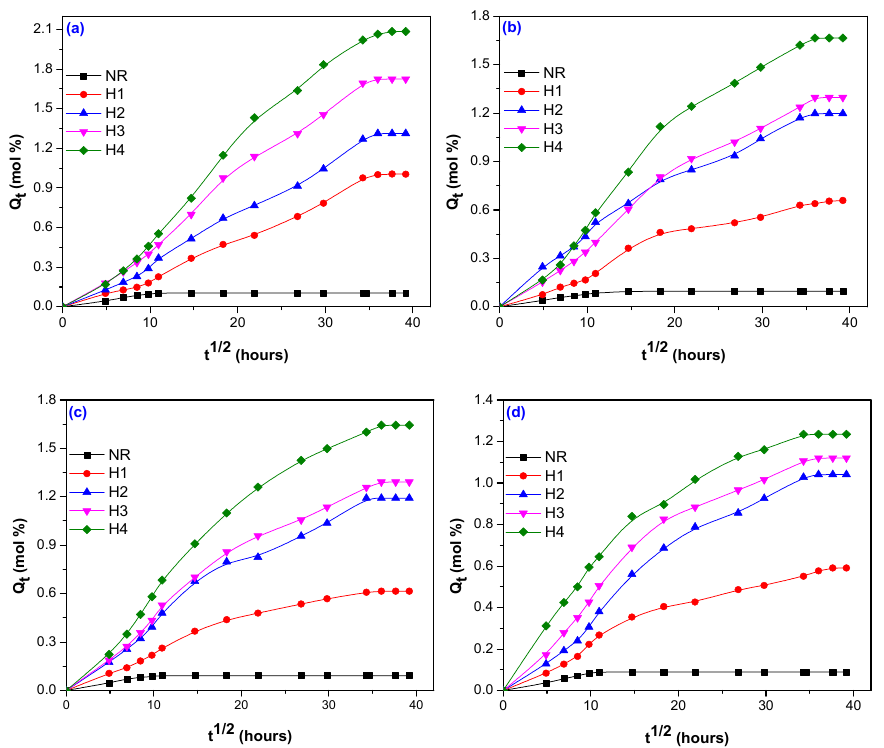
Figure 1. Q t variation versus immersion time for blends based on Natural rubber (NR) and hemp, irradiated at 75 kGy ( a ); 150 kGy ( b ); 300 kGy ( c ) ; and 600 kGy ( d ).